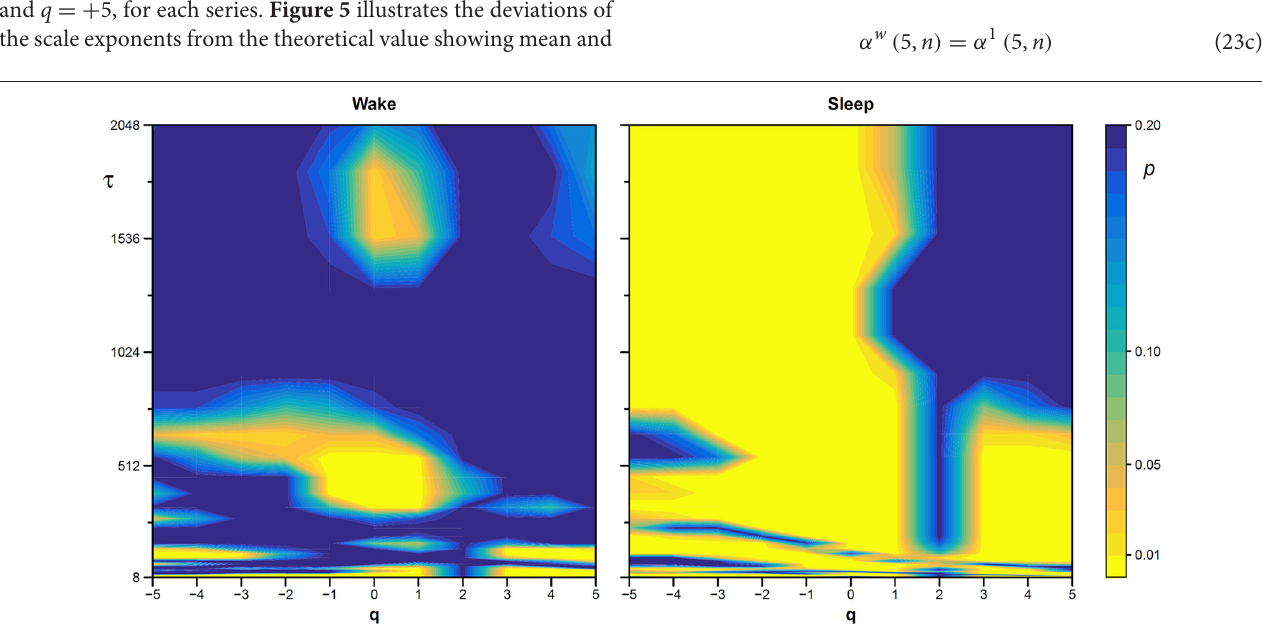
FIGURE 10 | Statistical significance of the nonlinearity test on scale coefficients of heart rate. Each point represents the two-sided, type-I error probability to reject the null hypothesis comparing scale coefficients of the original series and of Fourier-phase shuffled surrogate series at each scale τ and at each moment-order q ; differences significant at p < 0.01 are indicated in yellow. The temporal scale τ , in seconds, is obtained multiplying the box size, n , by the mean R-R interval (see Figure 8 ).